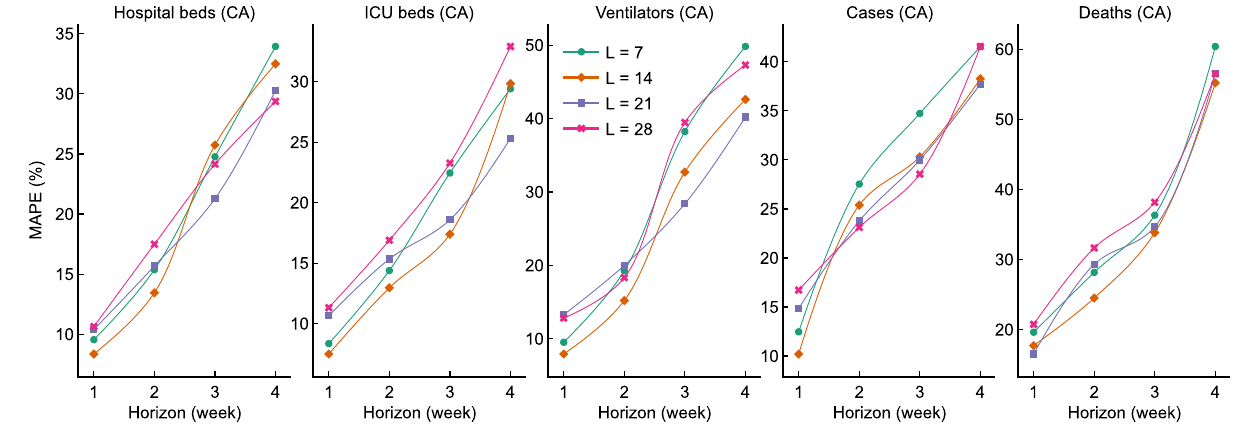
Figure 6. Comparison of the performance (in terms of MAPE) of TCN models using various past values as input.